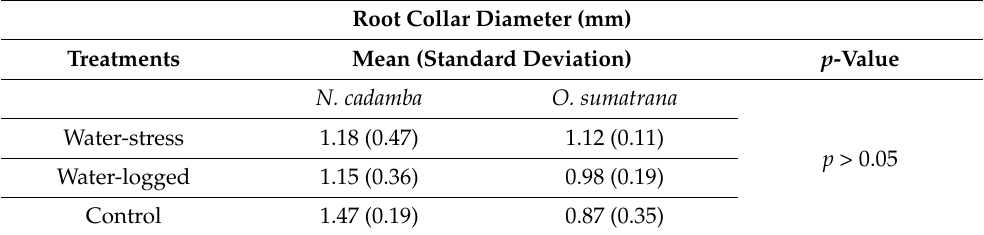
Table 3. Mean values of root collar diameter (mm) of N. cadamba and O. sumatrana seedlings under different treatments ( n = 3) were not significantly different ( p > 0.05) using two-way ANOVA followed by Tukey’s HSD post hoc.